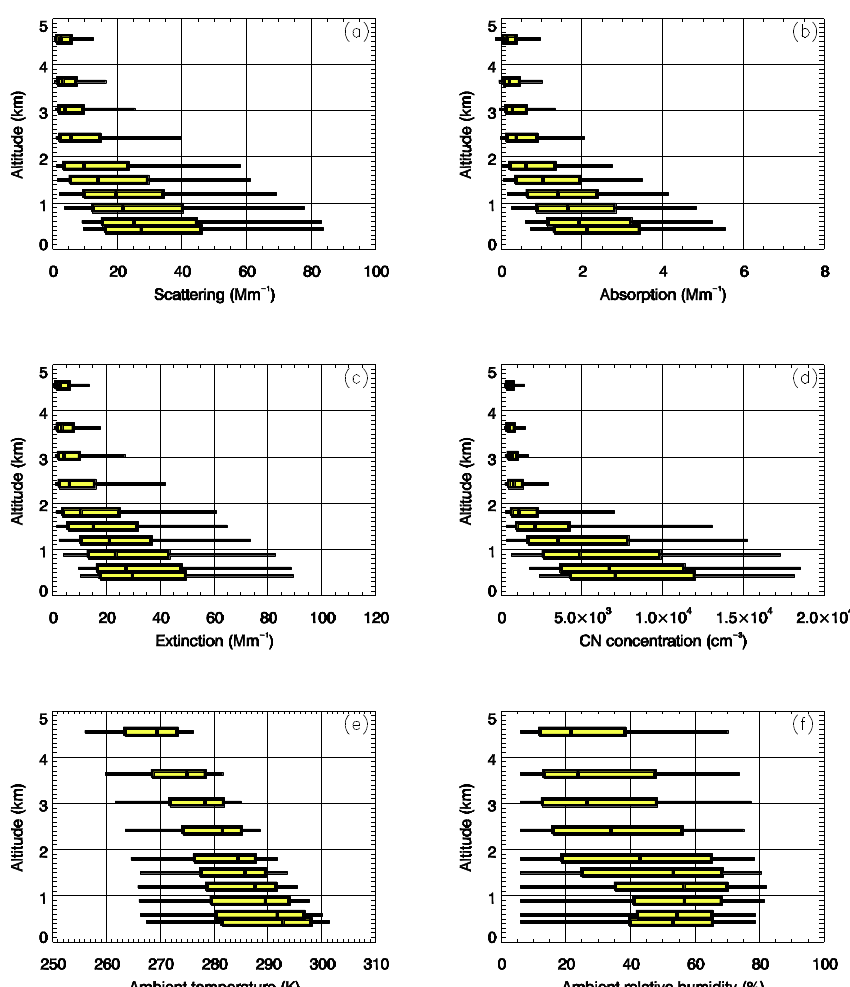
Fig. 8. Cumulative statistics of measured and calculated parameters for all AAO research profiles. Aerosol measurements are for dry (RH ≤ 40%) conditions and are adjusted to ambient temperature and pressure, with the exception of the CN concentration, which is reported at instrument temperature and pressure (volume flow rate used).